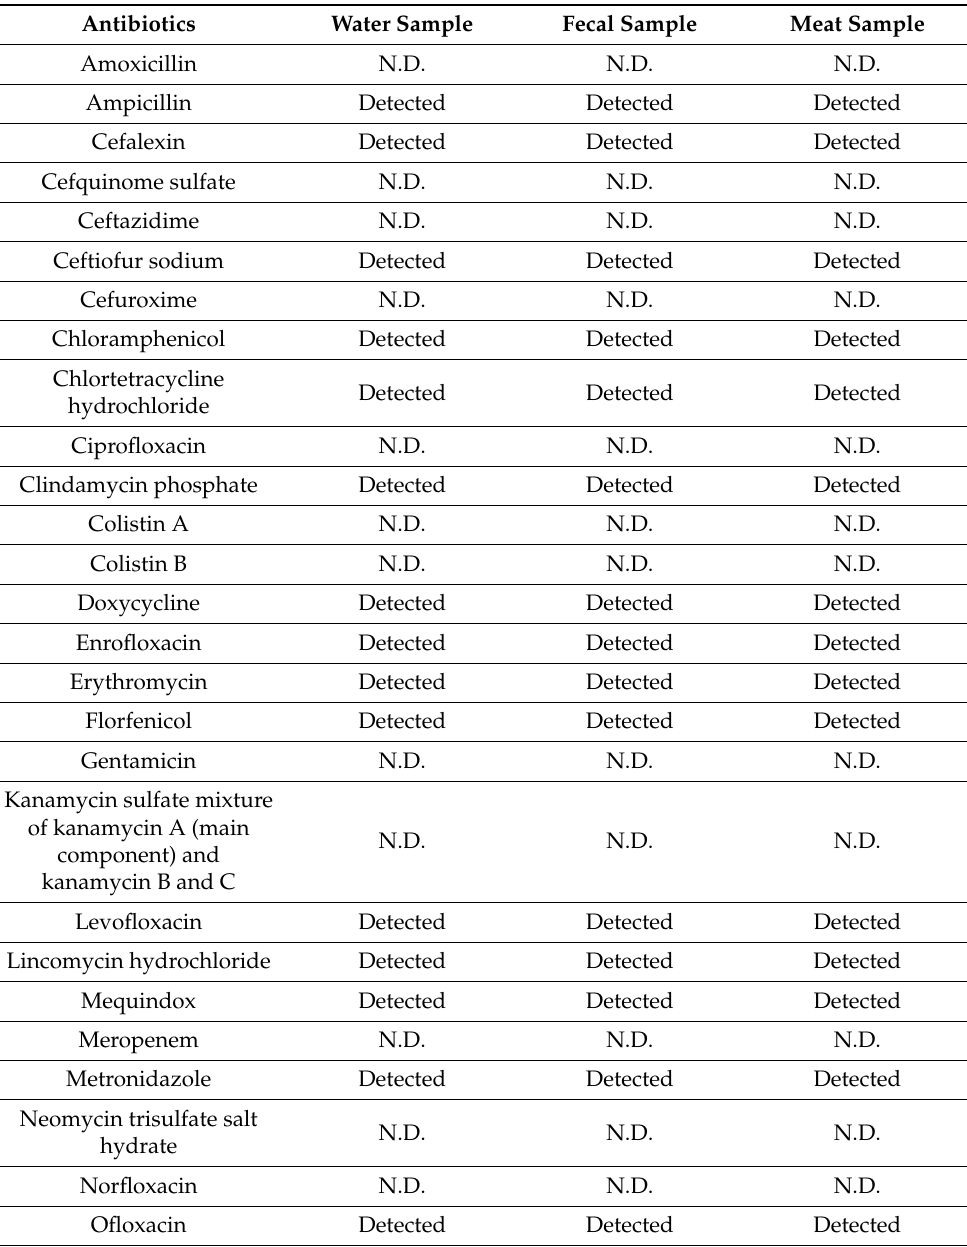
Table 4. Detection of antibiotic mixture for spike-in of water, fecal, and meat sample.